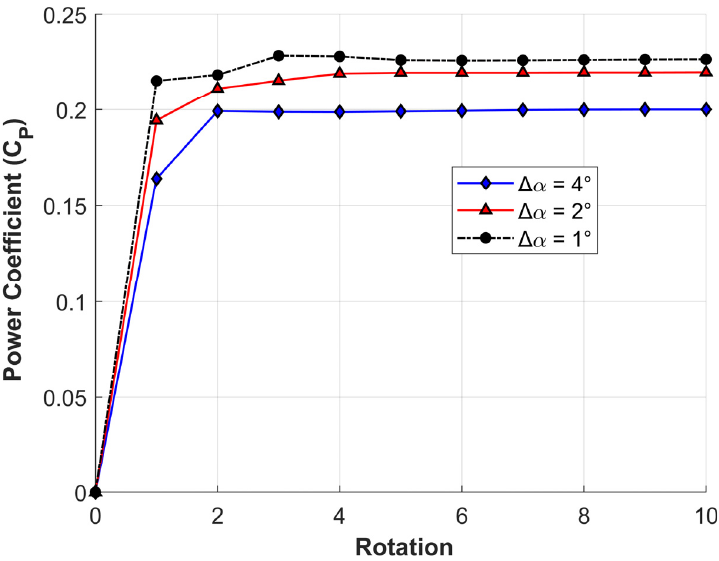
Figure 5. Power Coefficient Changes with the Number of Rotations for U ∞ = 8 m/s when adopting Different ∆α at λ = 1. Table 5. Timestep Independence Test for λ =1.